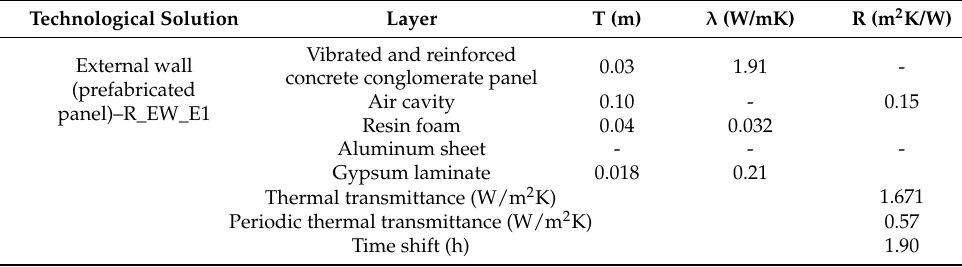
Table A18. Existing external wall stratigraphy (R_EW_E1).